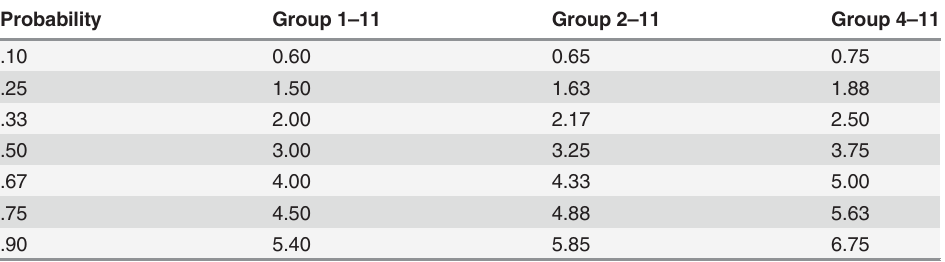
Table 1. Expected value of the high-uncertainty choice as a function of the probability of food for a high-uncertainty choice for each group in Experiment 1.